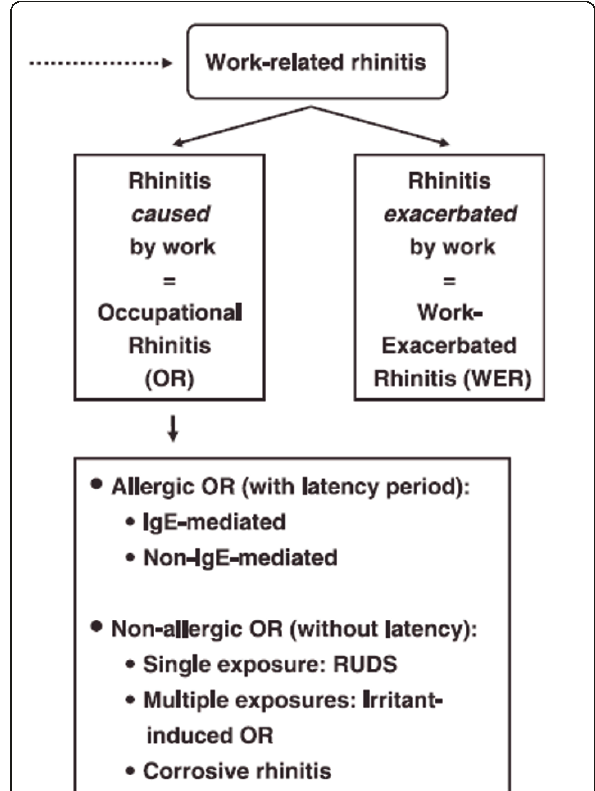
Figure 17 Occupational vs work-exacerbated rhinitis